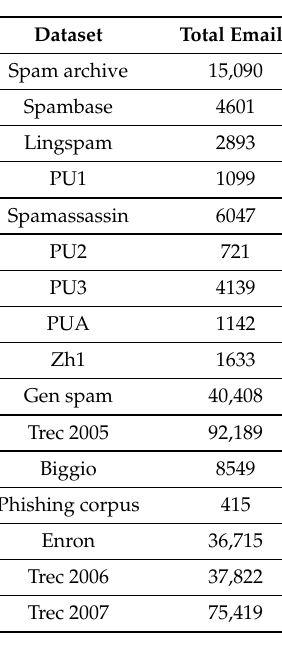
Table 3. A list of existing email datasets